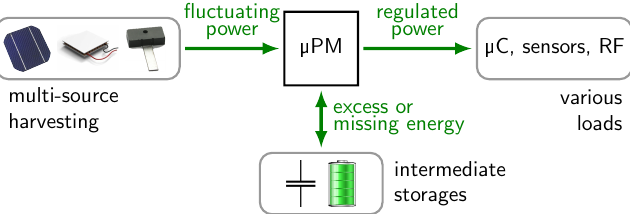
Figure 1. The micro-power management (µPM) supplies regulated power to a load from energy harvesting sources.